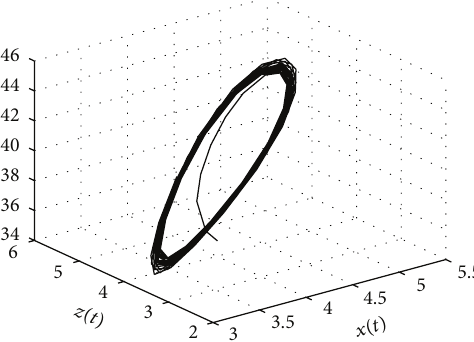
Figure 10: For system (97), there is chaos when 𝑘 1 = −3 , 𝜏 = 0.01 . Figure 11: For system (97), there is chaos when 𝑘 1 = −3 , 𝜏 = 0.051 .